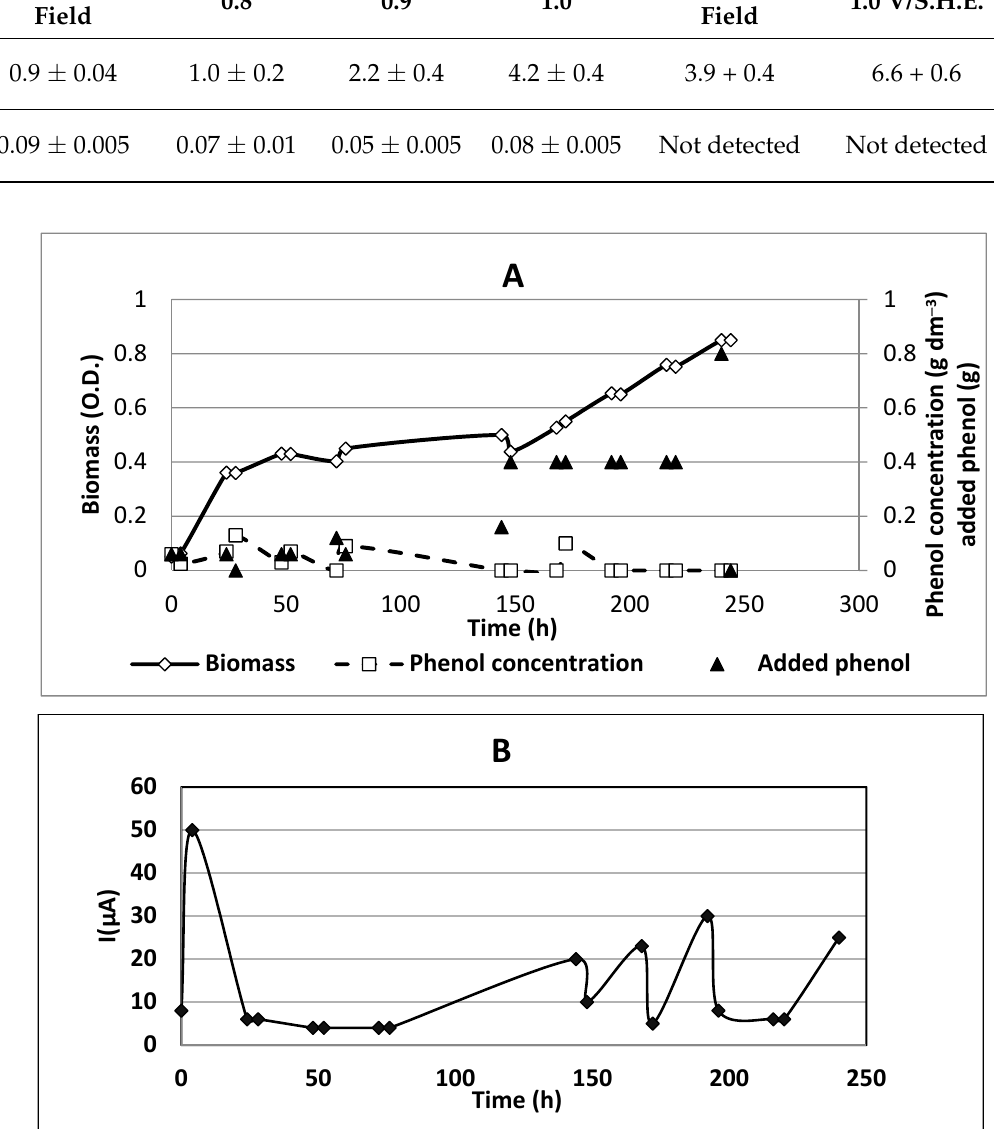
Figure 2. Time profiles for an experiment with free cells and the application of a constant electric field: ( A ) anode potential 1.0 V/S.H.E; ( B ) the current measured at anode potential 1.0 V/S.H.E. Initial phenol concentration, 0.06 gdm −3 .